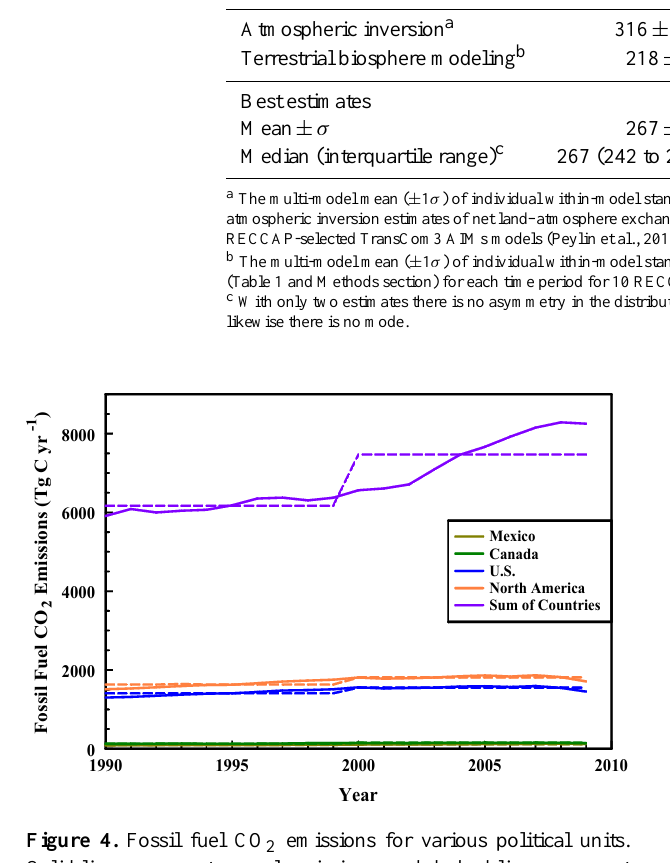
Figure 4. Fossil fuel CO 2 emissions for various political units. Solid lines represent annual emissions, and dashed lines represent the decadal mean of emissions. The sum of countries is used to rep- resent total global emissions in this plot. This allows comparison of emissions on an equal basis as all emissions are based on apparent consumption data and not production data (see Andres et al. (2012) for a fuller discussion of the differences). The global values used here are less than those in the CDIAC (Carbon Dioxide Information Analysis Center) archive (http://cdiac.esd.ornl.gov/trends/emis/tre_ glob_2010.html), mainly due to the exclusion of bunker fuels. Data from Boden et al.